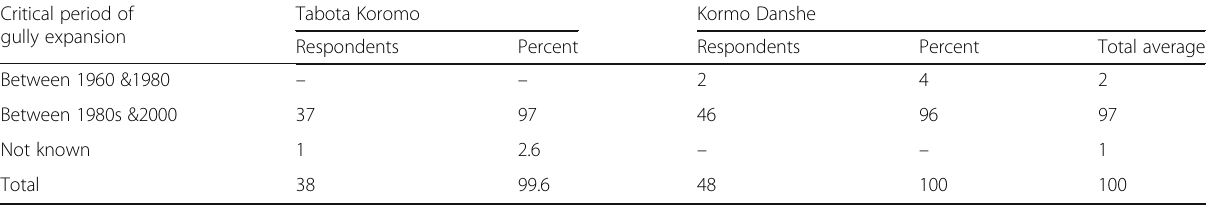
Table 6 Opinion of sample households on the period of gully expansion Critical period of gully expansion